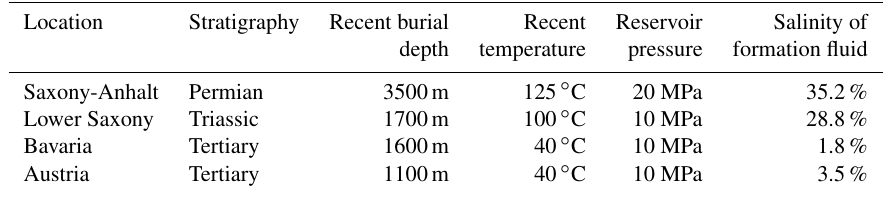
Table 1. Overview of the recent reservoir conditions of the sampled locations.